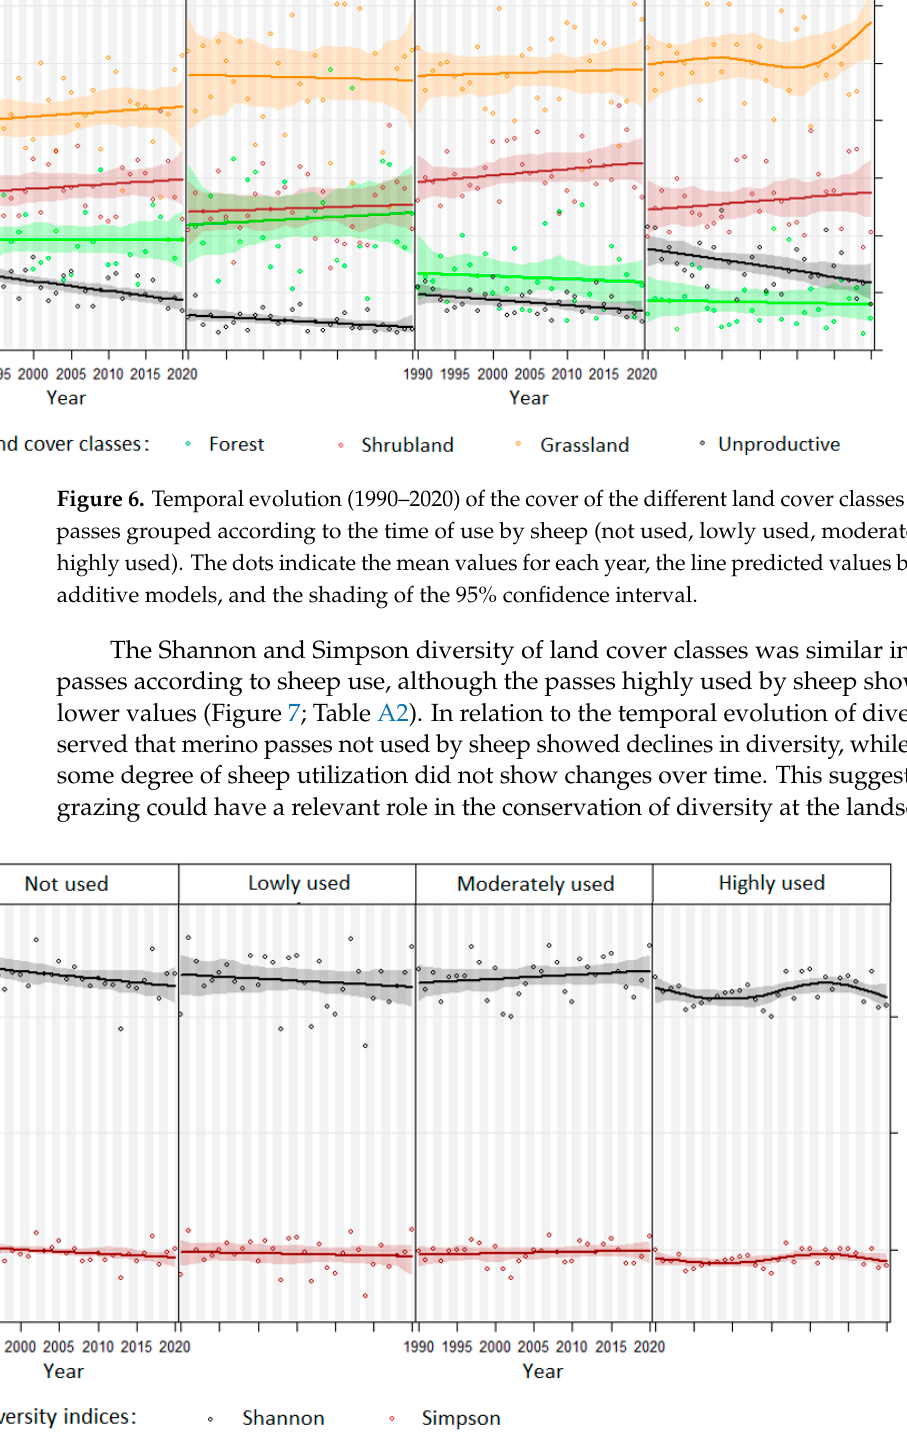
Figure 7. Temporal evolution (1990–2020) of landscape diversity estimated with Shannon and Simpson’s diversity indices in the merino passes grouped according to the time of use by sheep (not used, lowly used, moderately used, and highly used). The dots indicate the mean diversity values for each year, the lines predicted values by generalized additive models, and the shading of the 95% confidence intervals.